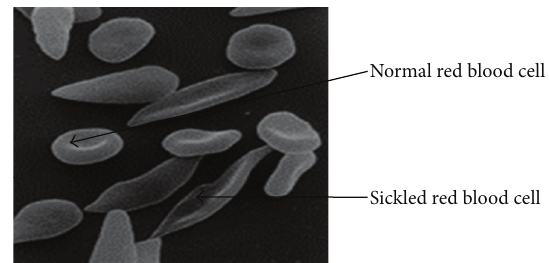
Figure 2: Normal and sickled red blood cells